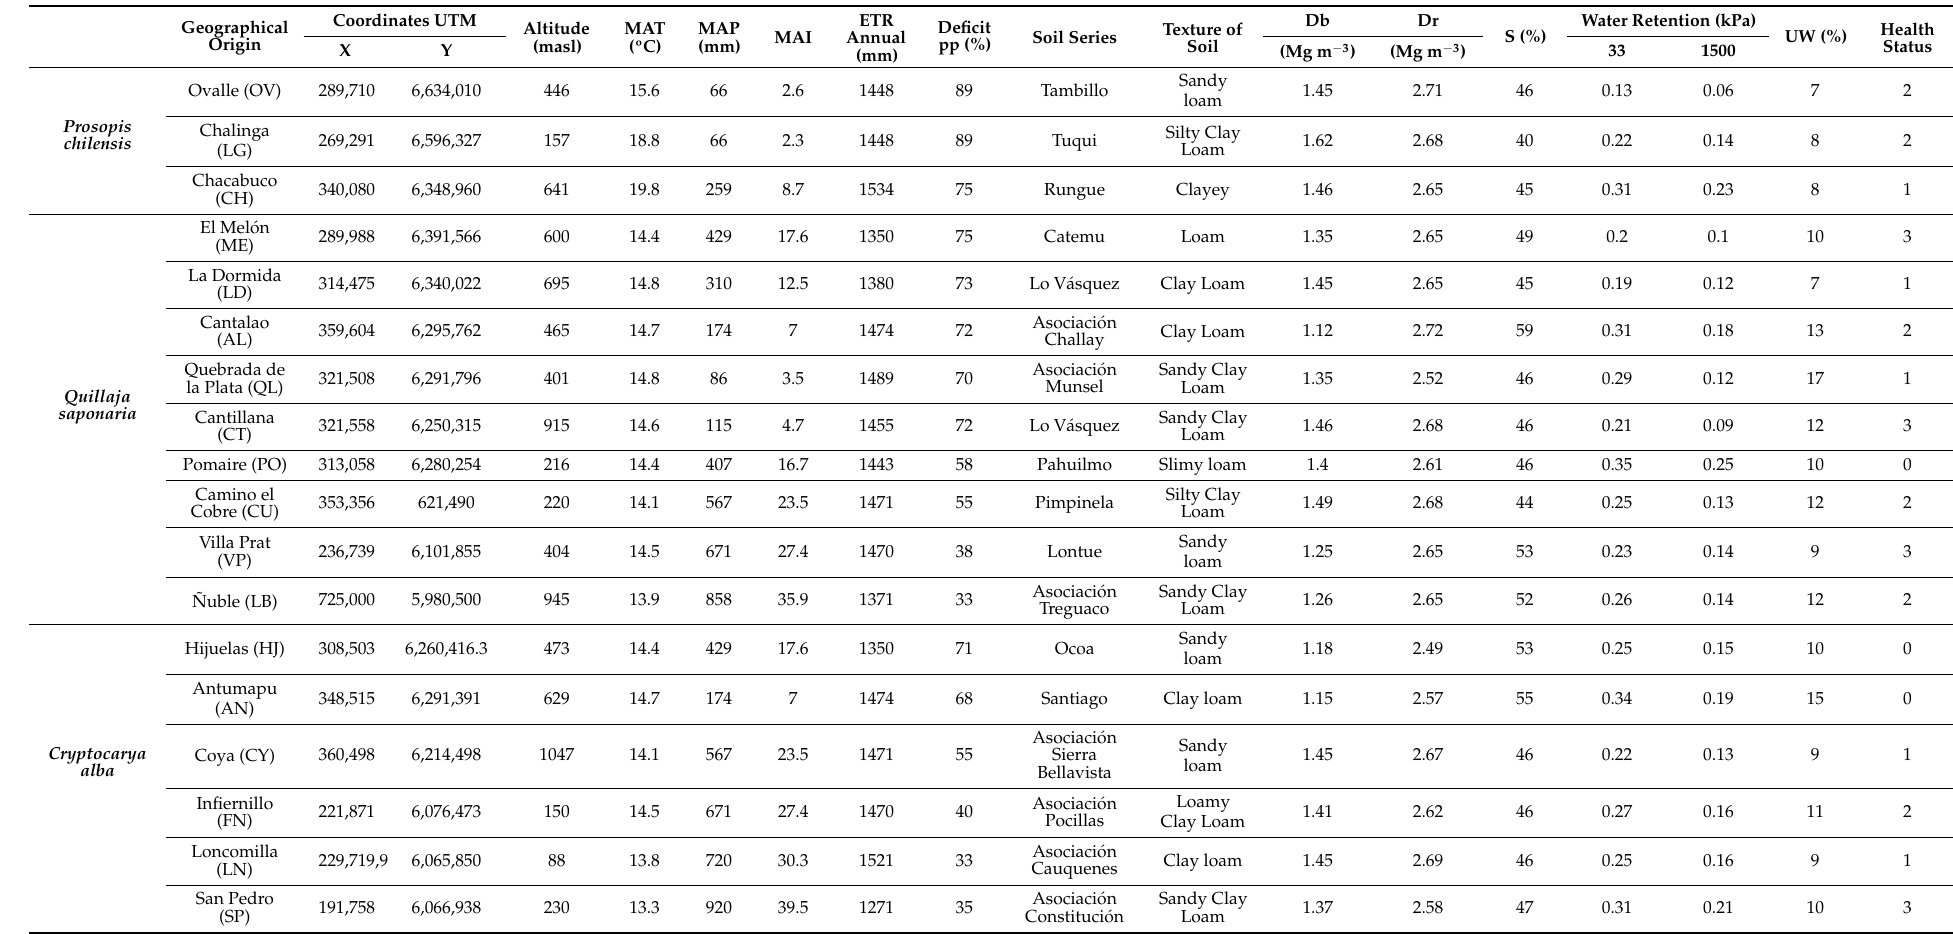
Table 5. Climatic and edaphic characteristics of the seed source. MAT= Mean Annual Temperature ( ◦ C); MAP= Mean Annual Precipitation (mm); MAI = Martonne aridity index (1926), S = Total Porosity (%), UW = usable water (%). Health status [48], Deficit pp = precipitation deficit last 12 years (%), ETR = Annual